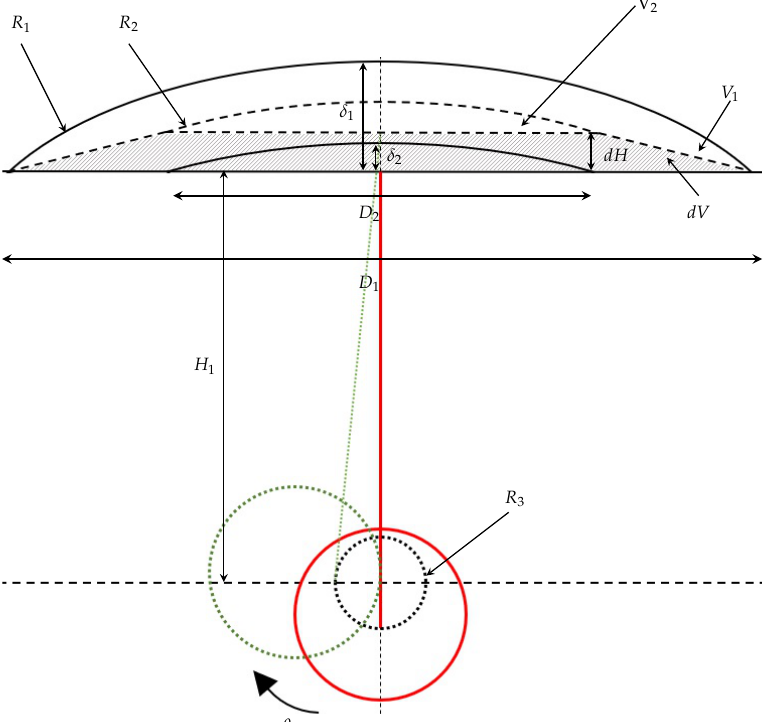
compressor is presented.